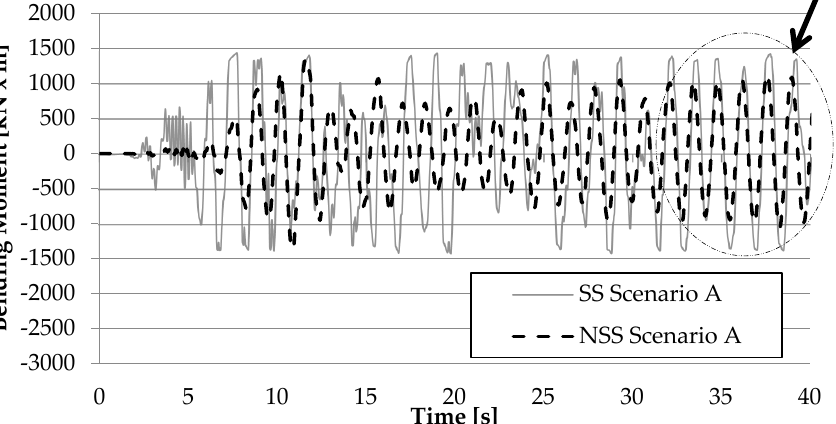
Figure 16. Comparison of moment My at the base of southern pile 14, time history BSC (Laviano)–load scenario A (unloading viaduct).